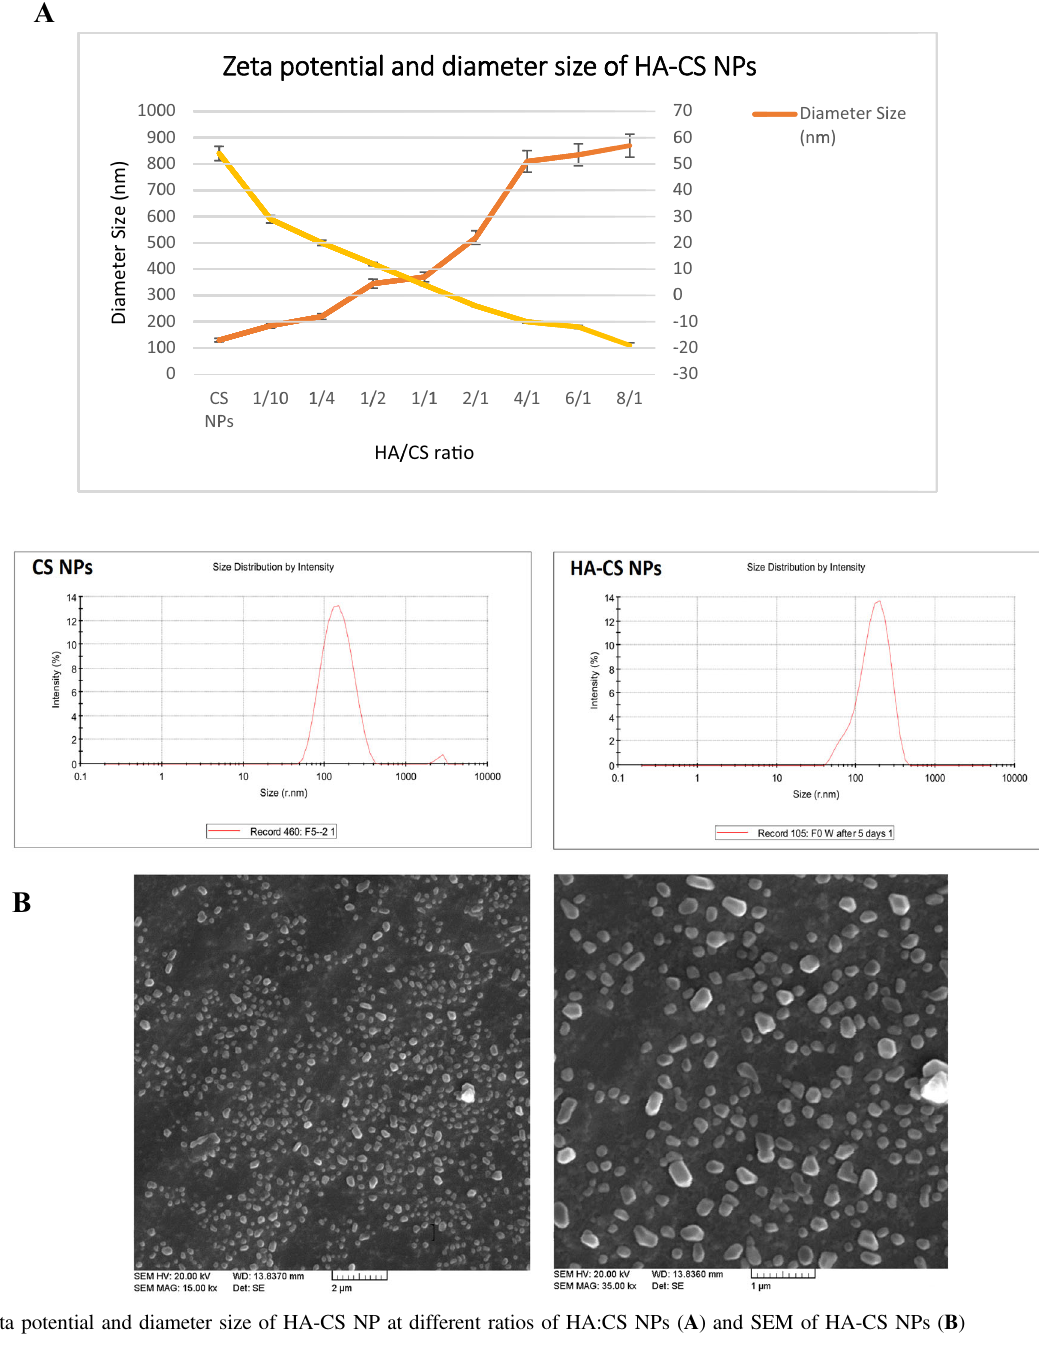
Fig. 2 Zeta potential and diameter size of HA-CS NP at different ratios of HA:CS NPs ( A ) and SEM of HA-CS NPs ( B